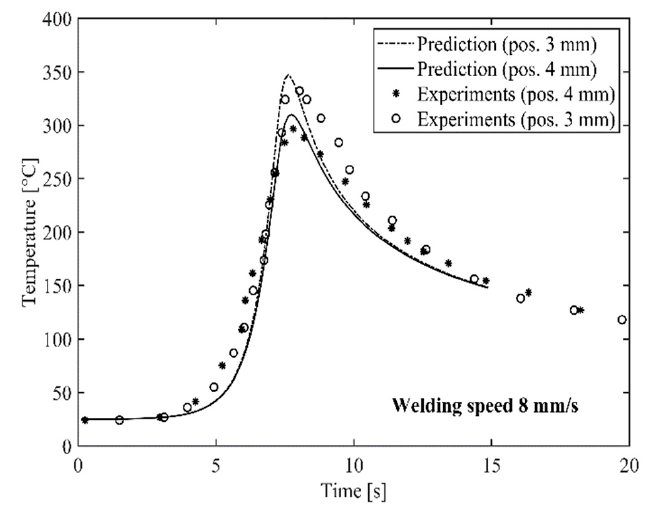
Figure 7. Comparison between predicted and measured thermal cycles for the butt weld produced at a welding speed of 6 mm/s. The indicated thermocouple locations are defined in Figure 6.